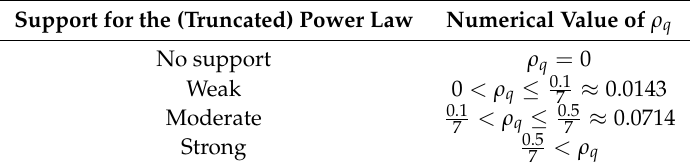
Table 3. Classification of the power law fit quality with respect to the quality ratio ρ q used in our study. Support for the (Truncated) Power